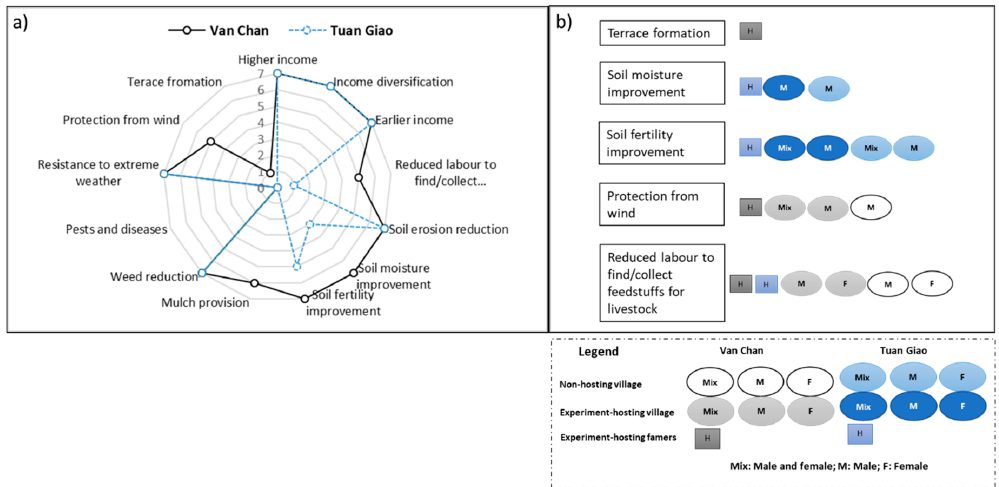
Figure 8. ( a ) Farmers’ perceptions about benefits of agroforestry systems and number of